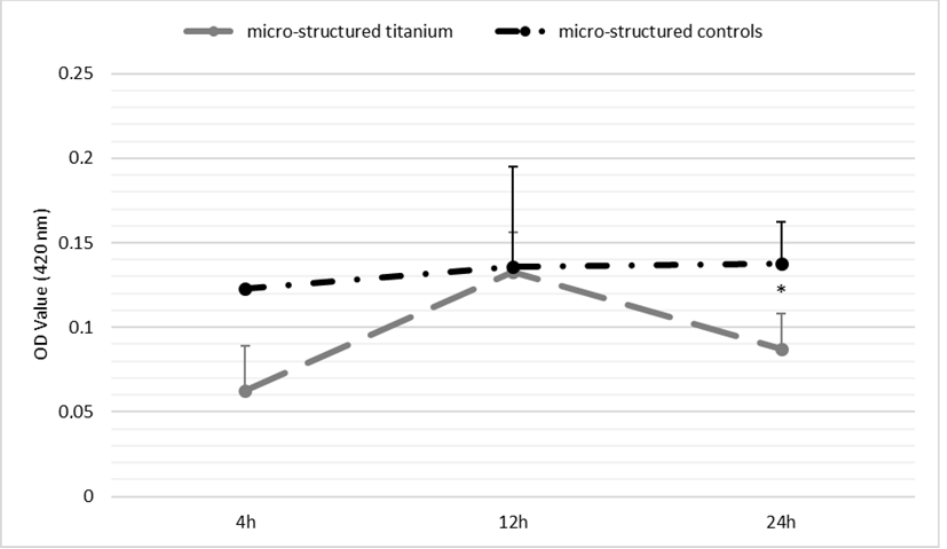
Figure A4. Comparison of cell proliferation in terms of WST-1 assay after 4, 12, 24 h between micro- structured titanium samples and controls. The circles correspond to the mean value, the line on top to the ± standard deviation. Statistically significant differences ( p < 0.05) are marked with an asterisk.